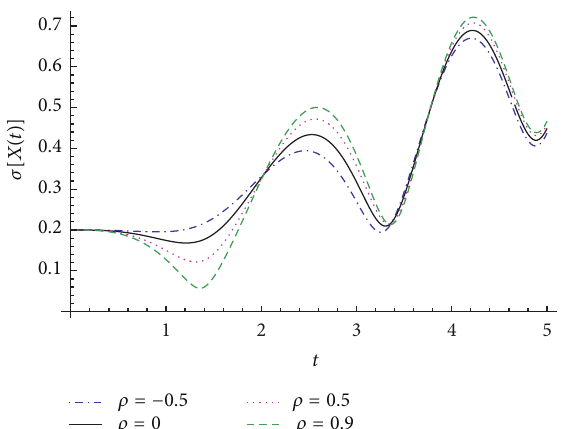
Figure 2: Comparison of the approximations for the standard deviation 𝜎[𝑋(𝑡)] on the time-interval 𝑡 ∈ [0, 5] for different ∈ {−0.5, 0, 0.5, 0.9} in Example 2 by correlation values 𝜌 = 𝜌 𝐴,𝑌 0 using Fr¨obenius, Polynomial Chaos, and Monte Carlo simulations. Since the numerical values are indistinguishable graphically, for the sake of clarity in the presentation, nonlabel has been introduced. We assume that 𝑌 1 = 1 and 𝜂 = (𝐴, 𝑌 0 ) ⊤ follows a bivariate Gaussian distribution: 𝜂 ∼ 𝑁( 𝜇 𝜂 ; Σ 𝜂 ) where, according to (34), 𝜇 𝐴 = 1 , = 1 , 𝜎 = 0.2 , 𝜎 = 0.2 . 𝜇 𝑌 0 𝐴 𝑌 0